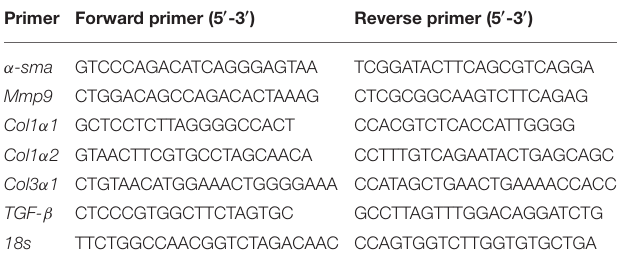
TABLE 1 | Primers used for real-time